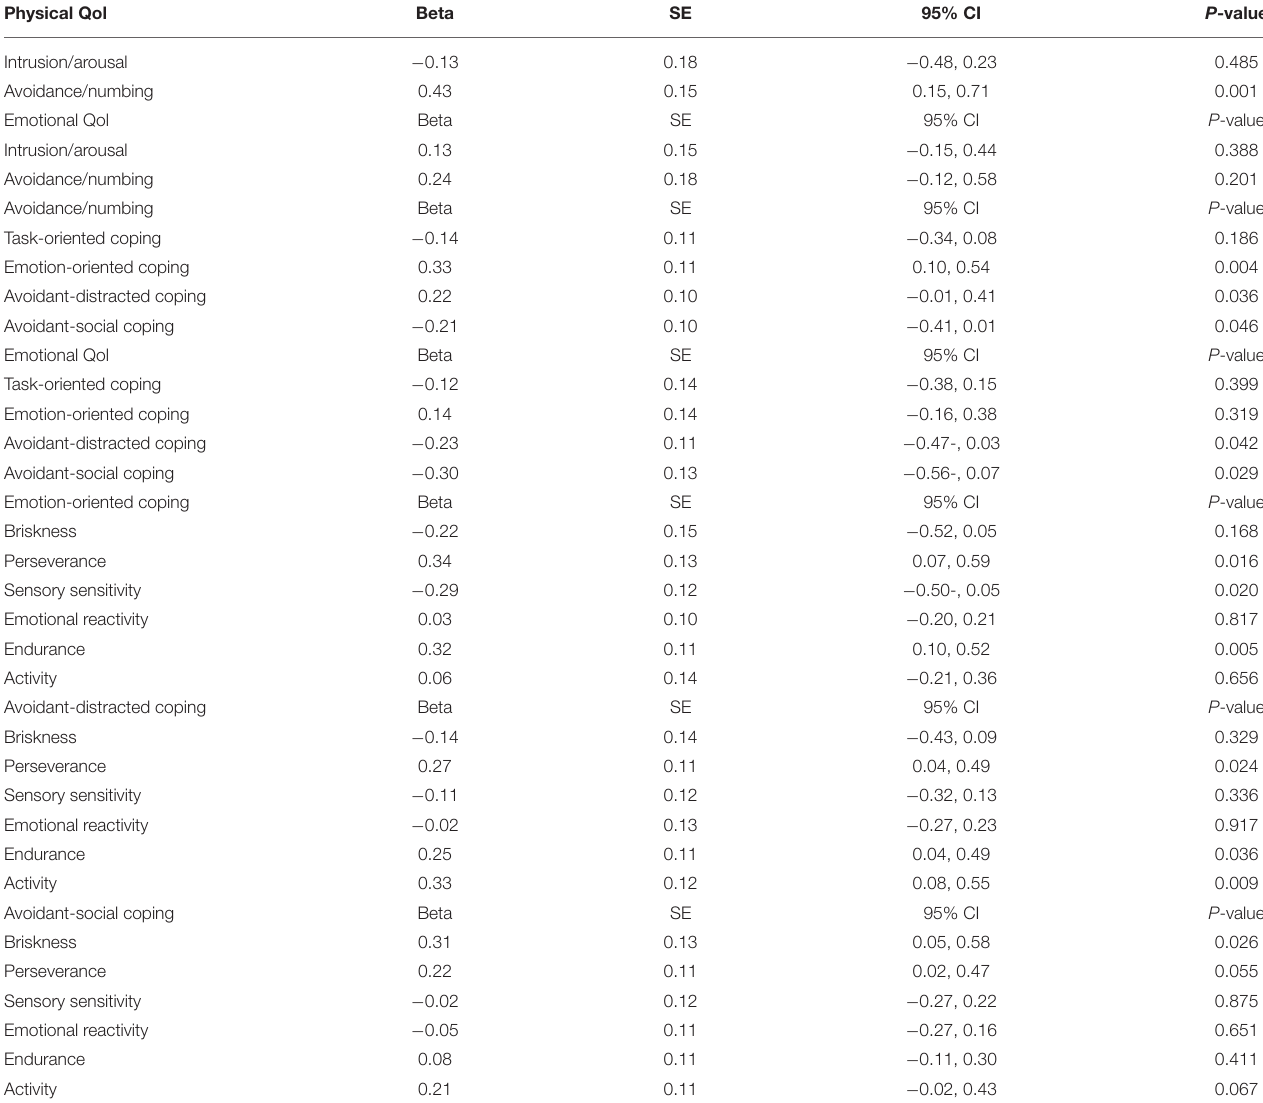
TABLE 3 | Estimates from regression models for subsequent stages. Physical Qol